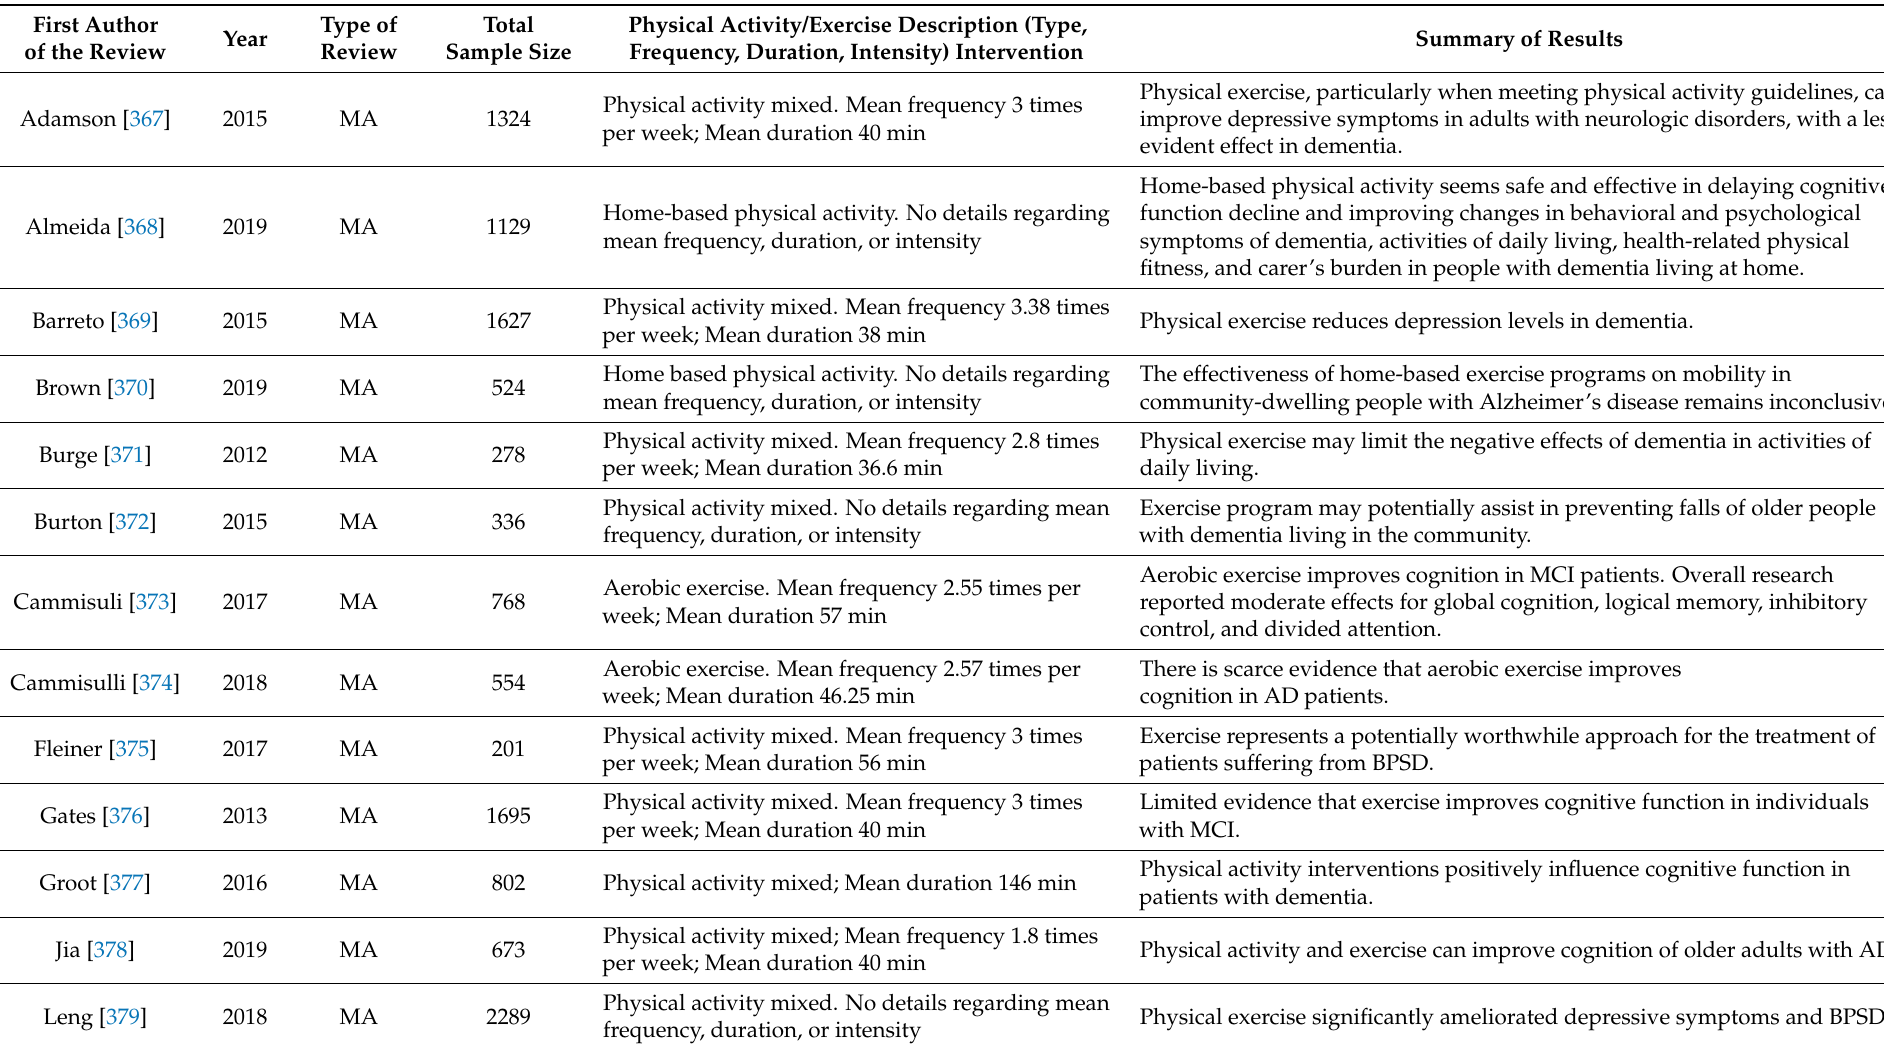
Table 2. Summary of systematic reviews and meta-analyses exploring the association of physical activity with cognitive decline and/or incident